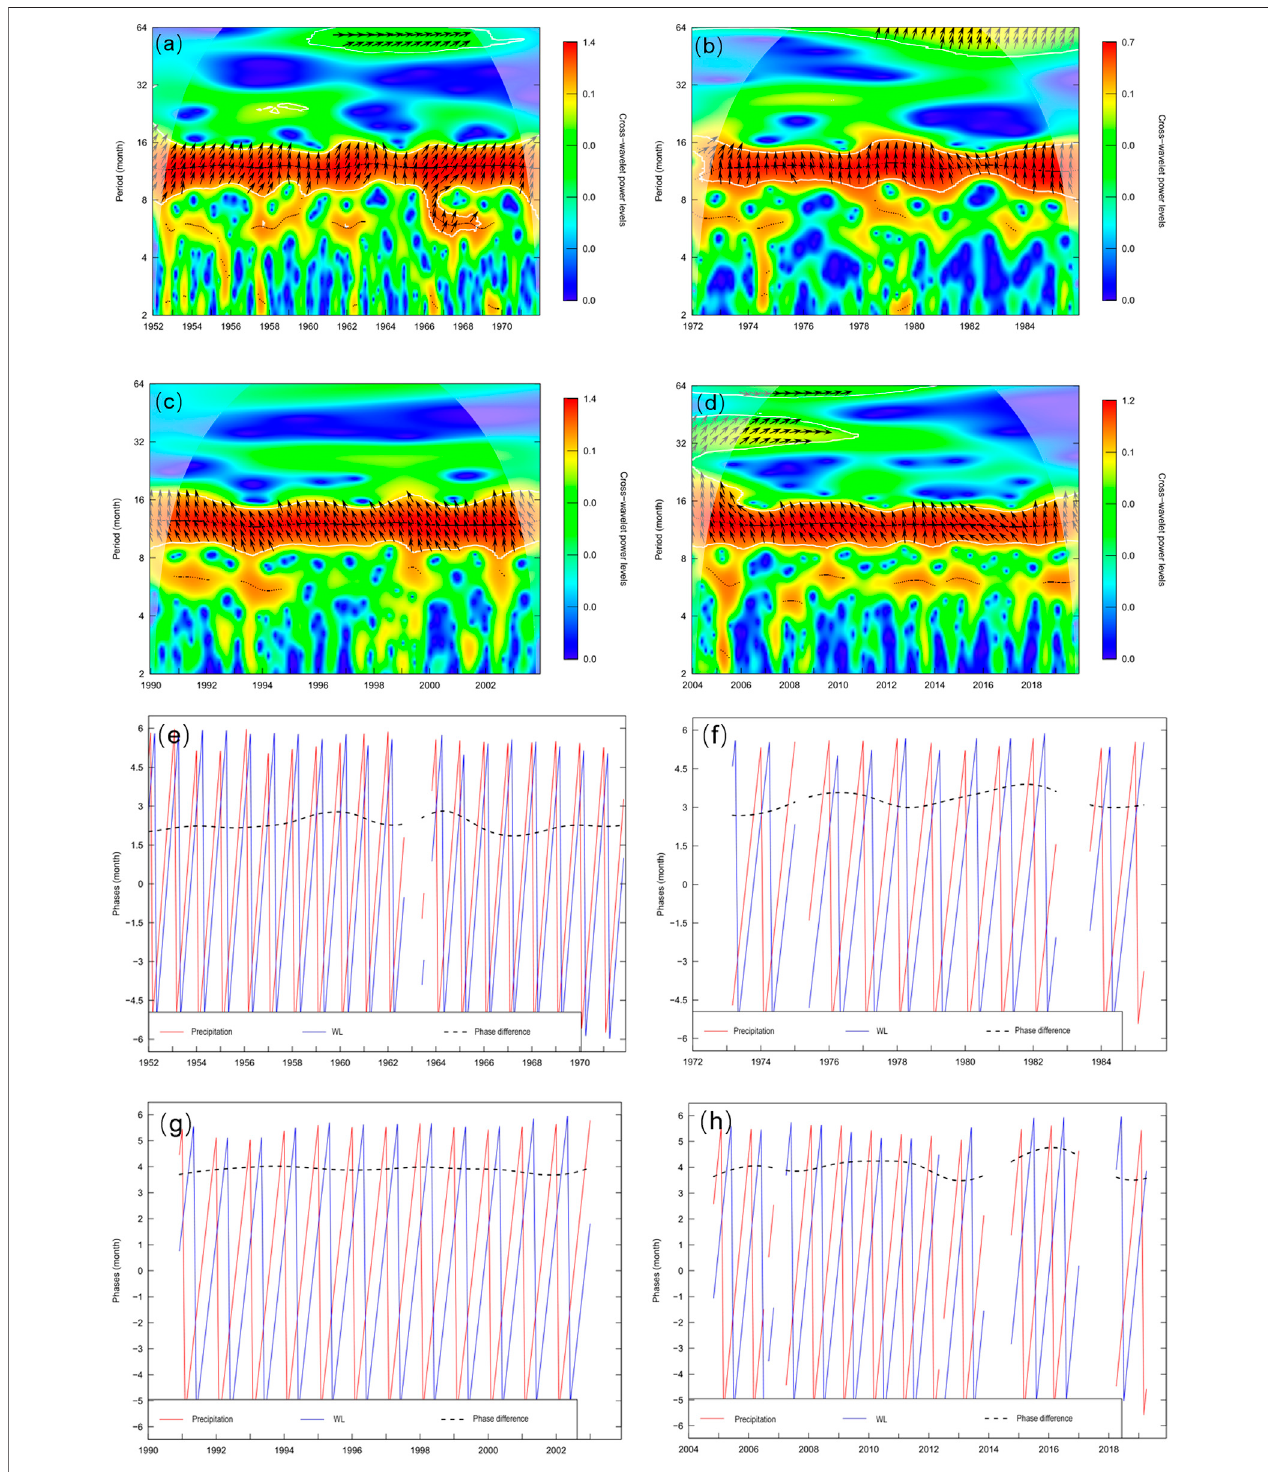
FIGURE 9 | Wavelet power analysis of precipitation and water level (WL) in different periods. (A – D) Wavelet coherency-image colors represent wavelet power spectrum. Blue U-shaped line is cone of in fl uence, below which edge effects limit con fi dence in results. Horizontal arrows on right indicate precipitation is in-phase with water level, on left indicate that two series are in antiphase, upward indicates that precipitation is 1/4 cycle ahead of water level, otherwise, 1/4 cycle behind. Arrows are plotted only with white contour lines indicating signi fi cance (concerning null hypothesis of white noise process) at the 1% level. Darker colors indicate stronger coherence between two series. (E – H) Phases and phase differences. Red line represents WL phase, blue line represents precipitation phase, and black dashed line represents phase differences.